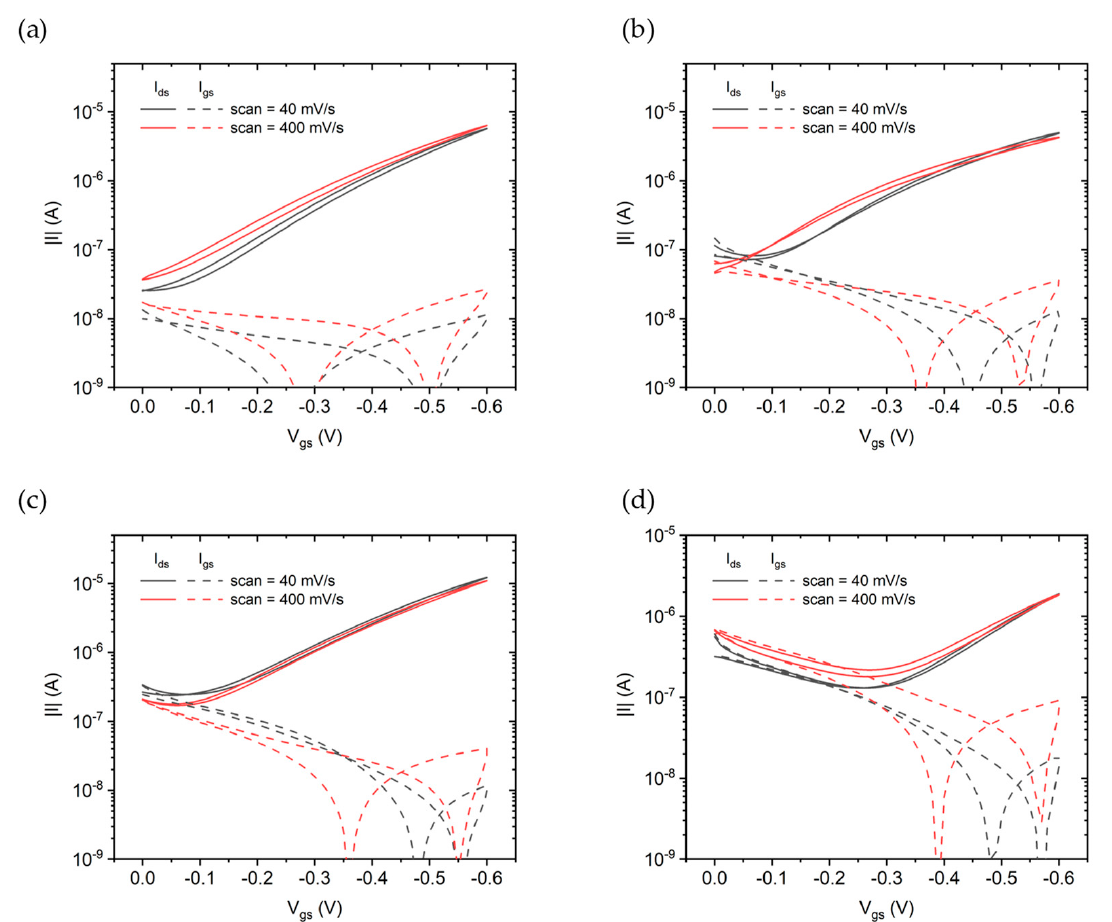
Figure 9. Transfer characteristics measured at scan rates of 40 mV / s (black curves) and 400 mV / s (red curves). Solid lines correspond to drain current while dashed lines are the gate leakage current. ( a ) No prime tol, ( b ) Ti prime tol, ( c ) No prime oDCB, and ( d ) Ti prime oDCB.